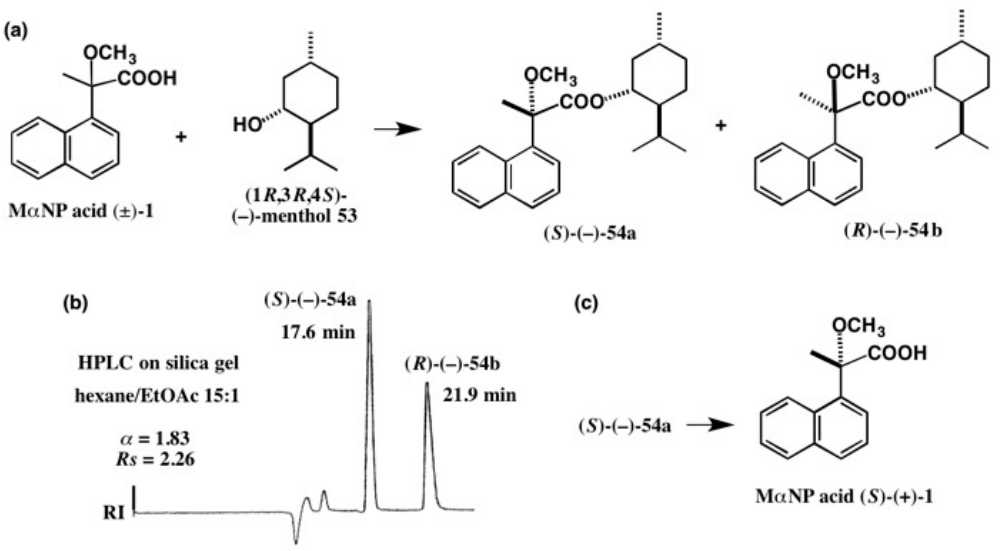
Figure 35. Preparation ( a ) and HPLC separation ( b ) of menthol M α NP esters 54a and 54b . ( c ) Recovery of M α NP acid ( S )-(+)- 1 from the first eluted ester ( − )- 54a . HPLC, reprinted with permission from [51].